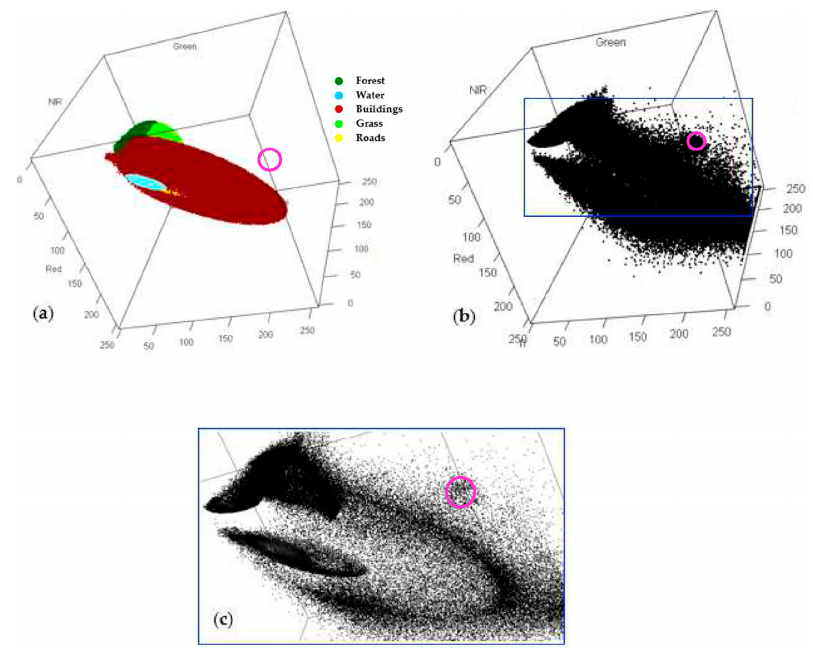
Figure 13. Three-dimensional scatterplots showing: ( a ) pixels assigned to individual LULC classes (excluding unclassified pixels) by the Bayes classification method; ( b ) unclassified pixels identified using the chi-square threshold technique with p c = 0.05; and ( c ) details of the blue box in ( b ). Pixels of the Beitou Depot of the Taipei MRT (purple-circled area) were identified as unclassified pixels. Remote Sens. 2016 , 8 , 705